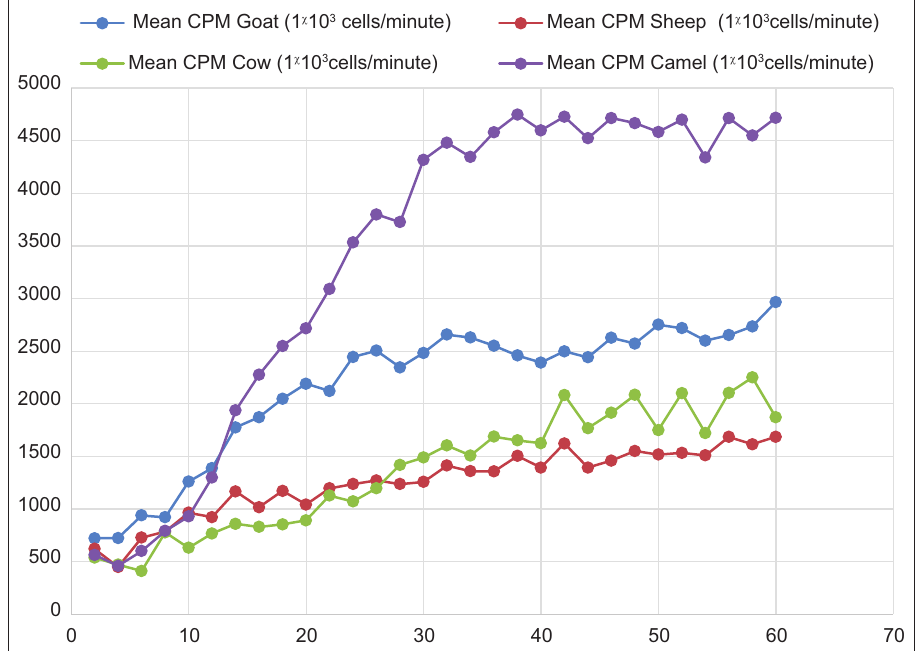
Figure-1: Comparison of luminol-dependent chemiluminescence of peripheral blood leukocytes from camels, goats, sheep, and cows.